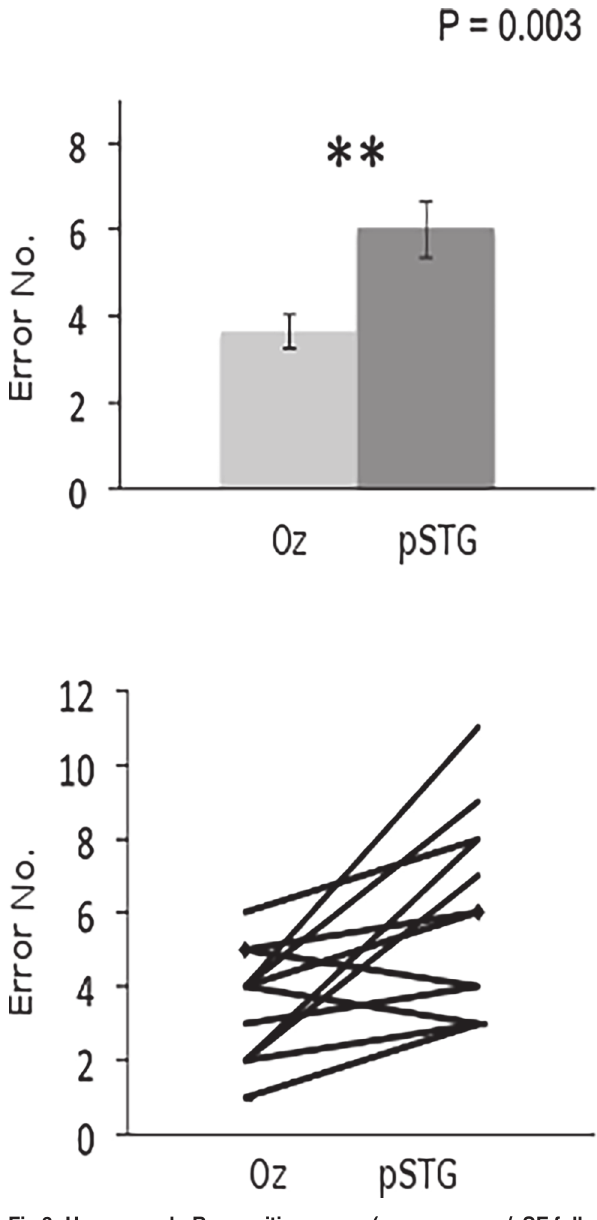
Fig 3. Upper graph: Recognition errors (group mean +/- SE following stimulation of Oz (control site) and pSTG (experimental site). Lower graph: Each participant's recognition errors following stimulation of Oz and pSTG. The line marked by diamond end-points represents the performance of three participants with the same scores.